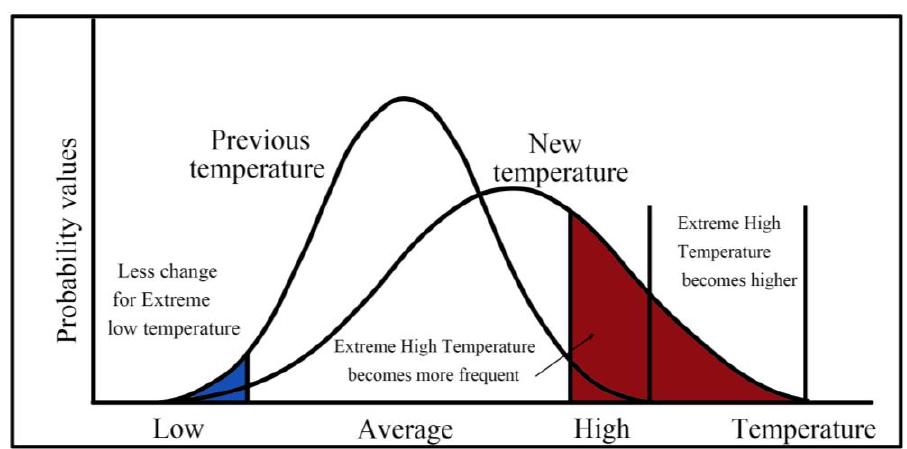
Figure 14. Theoretical changes in the distribution of climate variable values.